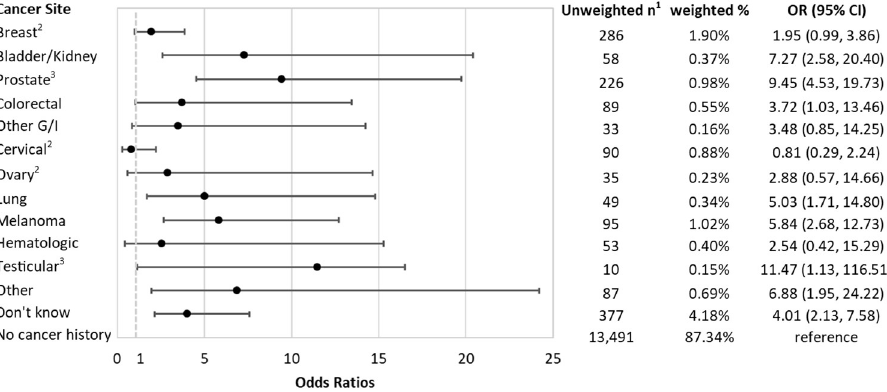
Fig 1. Odds ratios and 95% confidence intervals of elevated 10-year ASCVD risk (PCEs � 7.5), by cancer sites, compared to those without cancer. Logistic regression adjsted for BMI, marital status, education level, income to poverty ratio, dietary intake, physical activity, and depression score. 1 Unweighted sample size. All other analyses incorporated the NHANES sample weights. Adjusted Model controlled for BMI, race, marital status, education level, income to poverty ratio, dietary intake, physical activity, and depression score. Other G/I cancer included esophagus, gallbladder, liver, pancreas, and stomach; other cancer included bone, brain, nervous system, soft tissue, more than 3 cancers, and reported as other. 2 with female participants as the comparison. 3 with male participants as the comparison. Effect estimates for cancer in uterus and thyroid were not estimated due to small sample size to calculated population-weighted